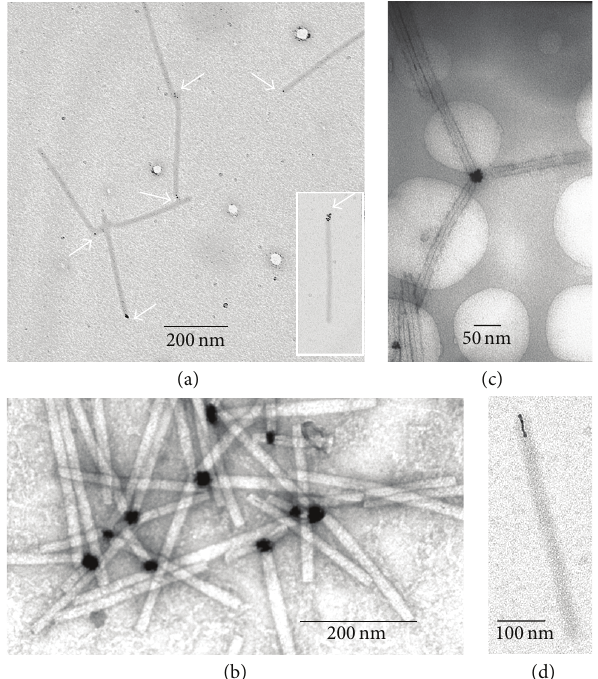
Figure 1: Polar growth of the platinum atom clusters on the TMV platform. Platinum nanoparticles were formed after chemical reduction of (dien)platinum by sodium borohydride to a final concentration of 3mM (a) or 10mM ((b)–(d)), see Section 2). Samples were examined with transmission electron microscopes Zeis LEO912 AB OMEGA supplied with the energy filter (specimens ((a), (d)) and Jeol JEM 1011 (specimens (b), (c)). No staining of specimens ((a), (d)) was carried out. Samples ((b), (c)) were stained slightly with 2% uranyl acetate. Arrows in (a) indicate the platinum atom clusters bound to the end of the virus